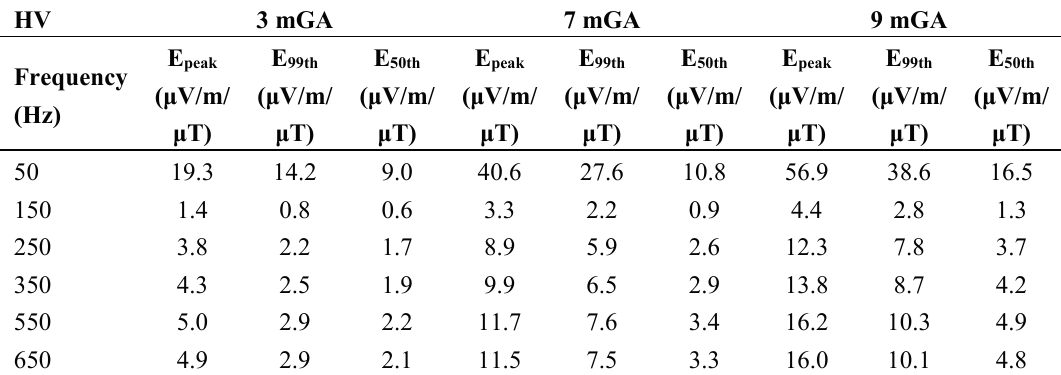
Table 5. Whole-body foetus induced electric field E peak , E 99th and E 50th at 3, 7 and 9 months GA, for each frequency, per μ T of B peak,50Hz, calculated according to the percentage provided by the standard EN 50160 in case of HV electricity transmission networks